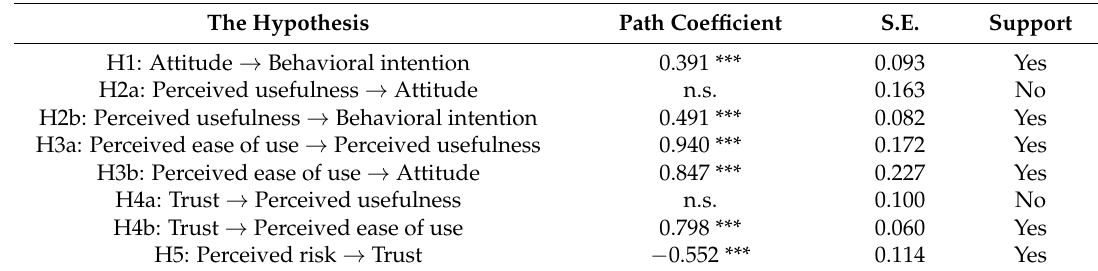
Table 5. Model path